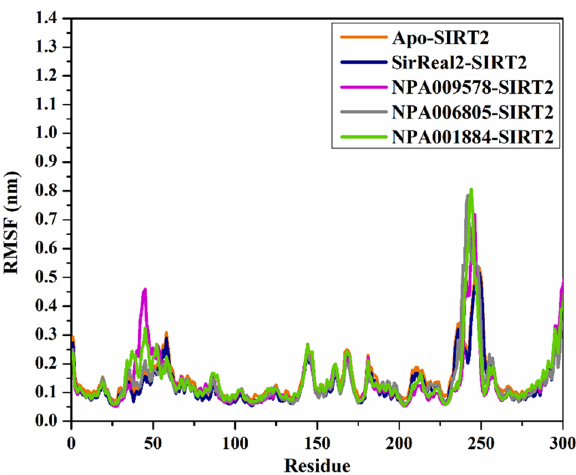
Figure 10. RMSF of the C α atoms of apo and ligand-soaked SIRT2 protein throughout 200 ns MD simulation. Color Scheme: Apo SIRT2 (in orange), SirReal2-SIRT2 (in navy), NPA009578-SIRT2 (in pink), NPA006805- SIRT2 (in gray), and NPA001884-SIRT2 (in